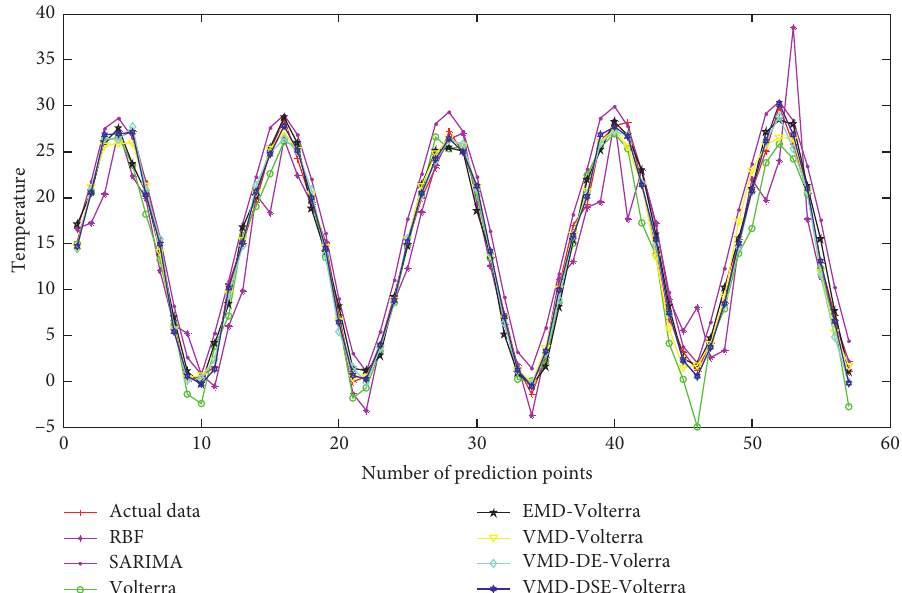
Figure 9: Prediction results for each model in